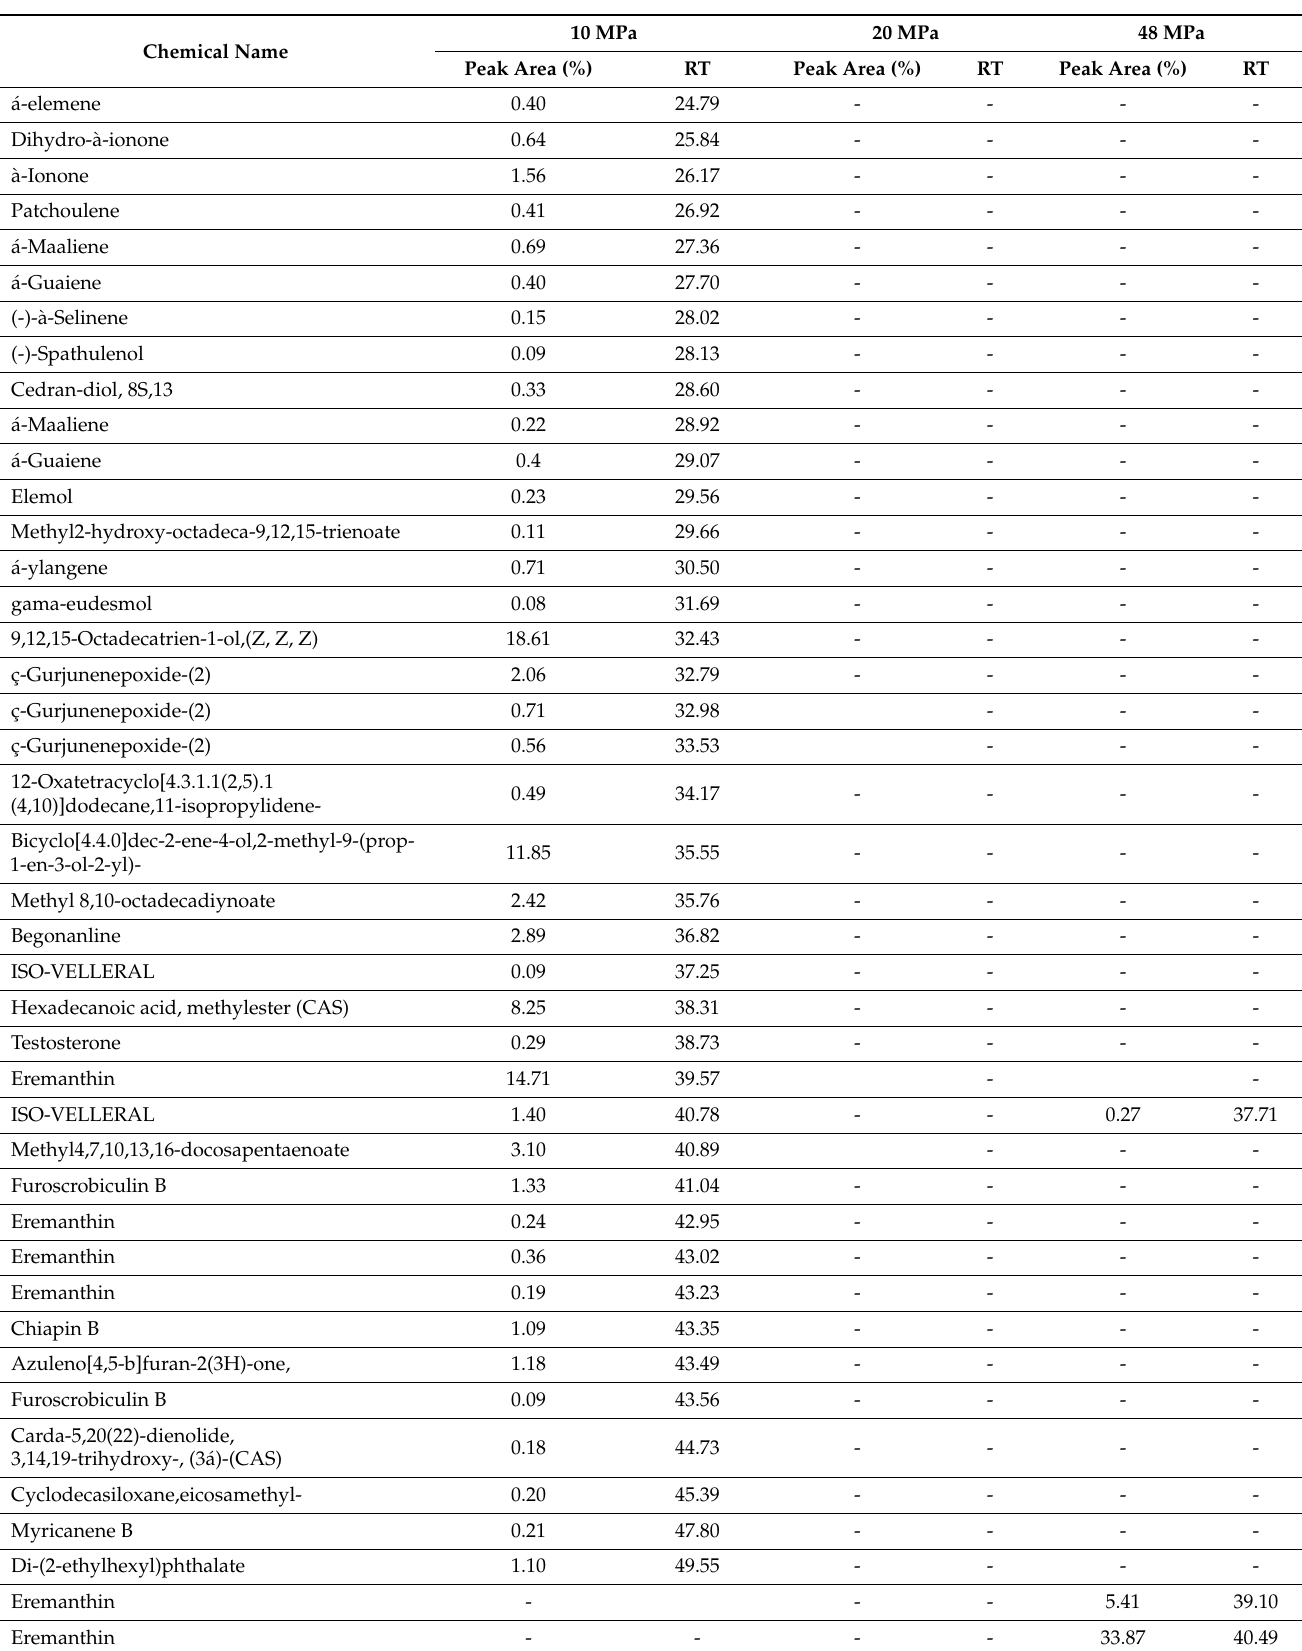
Table 1. Chemical constituents identified from the S. costus extract by SFE at different